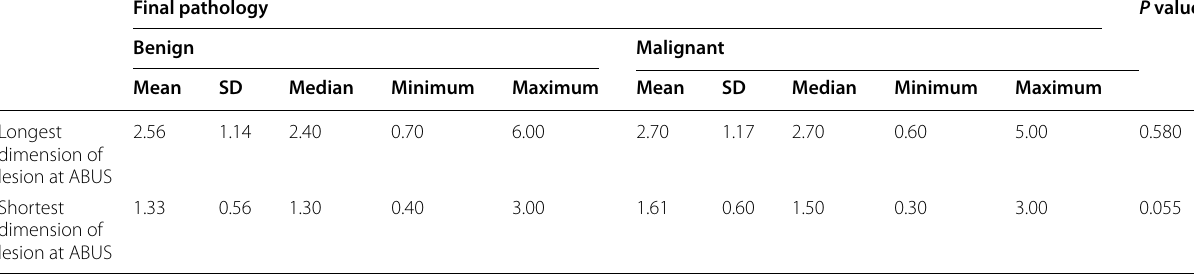
Table 12 Correlation between lesion size and pathology at